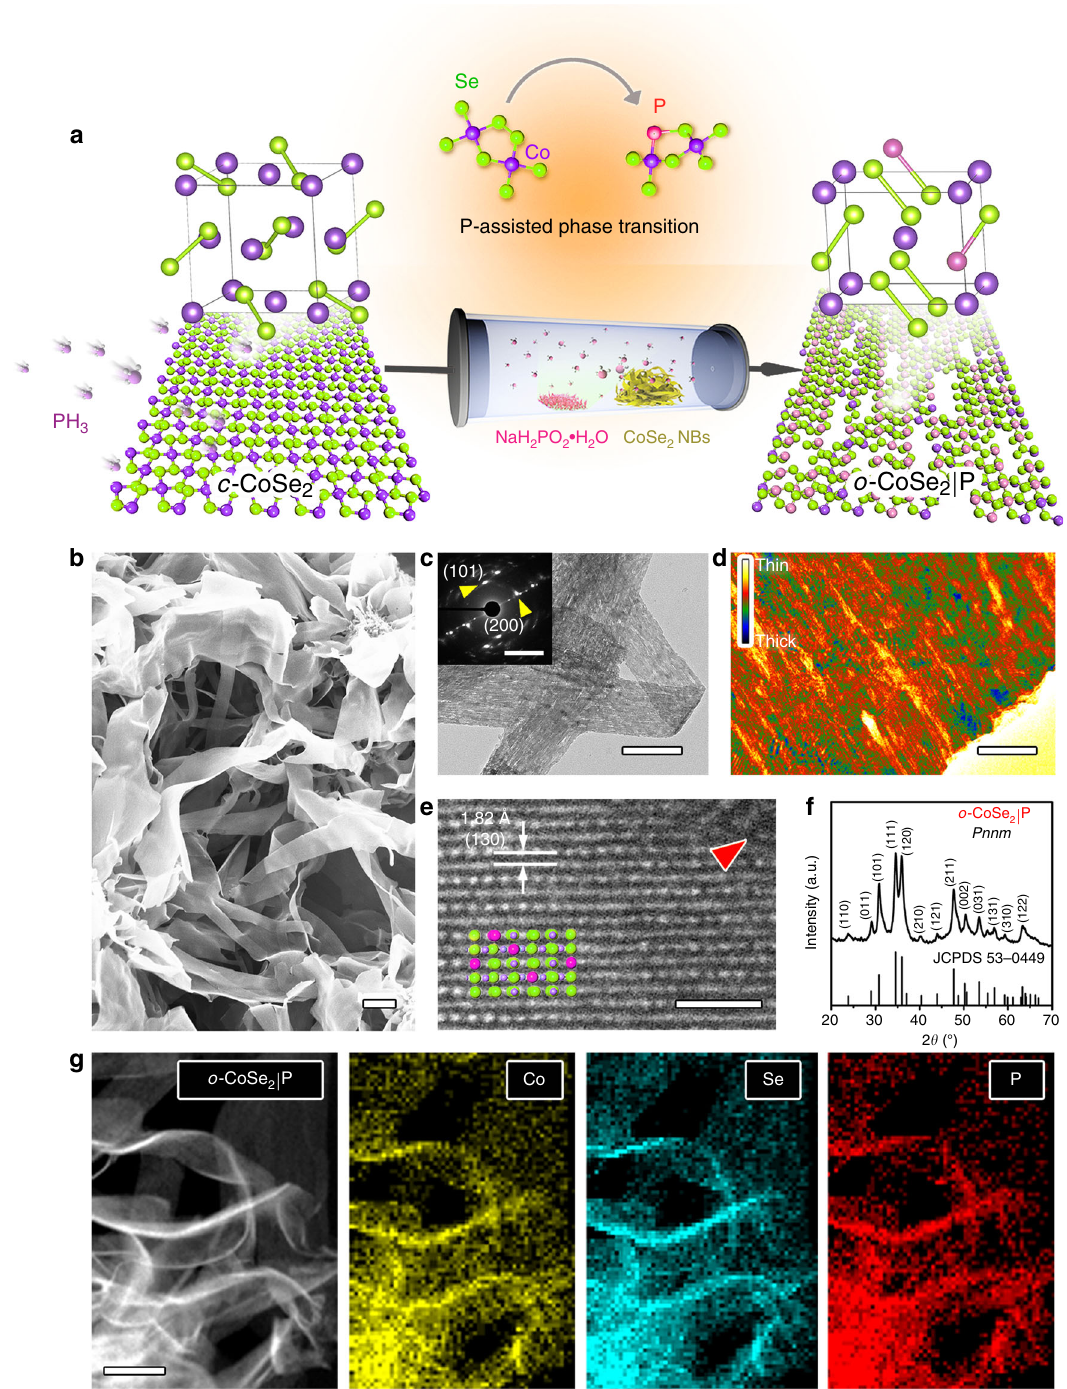
Fig. 1 Synthesis and physical characterization of o -CoSe 2 |P. a Schematic illustration of the P-doping-assisted structural phase transition from c -CoSe 2 to o - CoSe 2 |P through an annealing process. Violet, green, and pink balls correspond to Co, Se, and P atoms, respectively. b , c SEM (scale bar, 400 nm) and TEM (scale bar, 200 nm) images of o -CoSe 2 |P nanobelts. Inset in c shows corresponding SAED pattern. Scale bar, 5 nm – 1 . d False-color HAADF image indicates the relative thickness of a porous o -CoSe 2 |P nanobelt. Scale bar, 40 nm. e HAADF-STEM image of the o -CoSe 2 |P. Red arrow in e indicates atomic defects at the pore edge. The o -CoSe 2 |P crystal structure is shown in e with Co, Se, and P in blue, green, and pink, respectively. Scale bar, 1 nm. f Typical XRD pattern of the marcasite o -CoSe 2 |P. g STEM-EDX elemental mapping of o -CoSe 2 |P revealing clearly the homogeneous distribution of Co (yellow), Se (azure), and P (red), respectively. Scale bar, 200